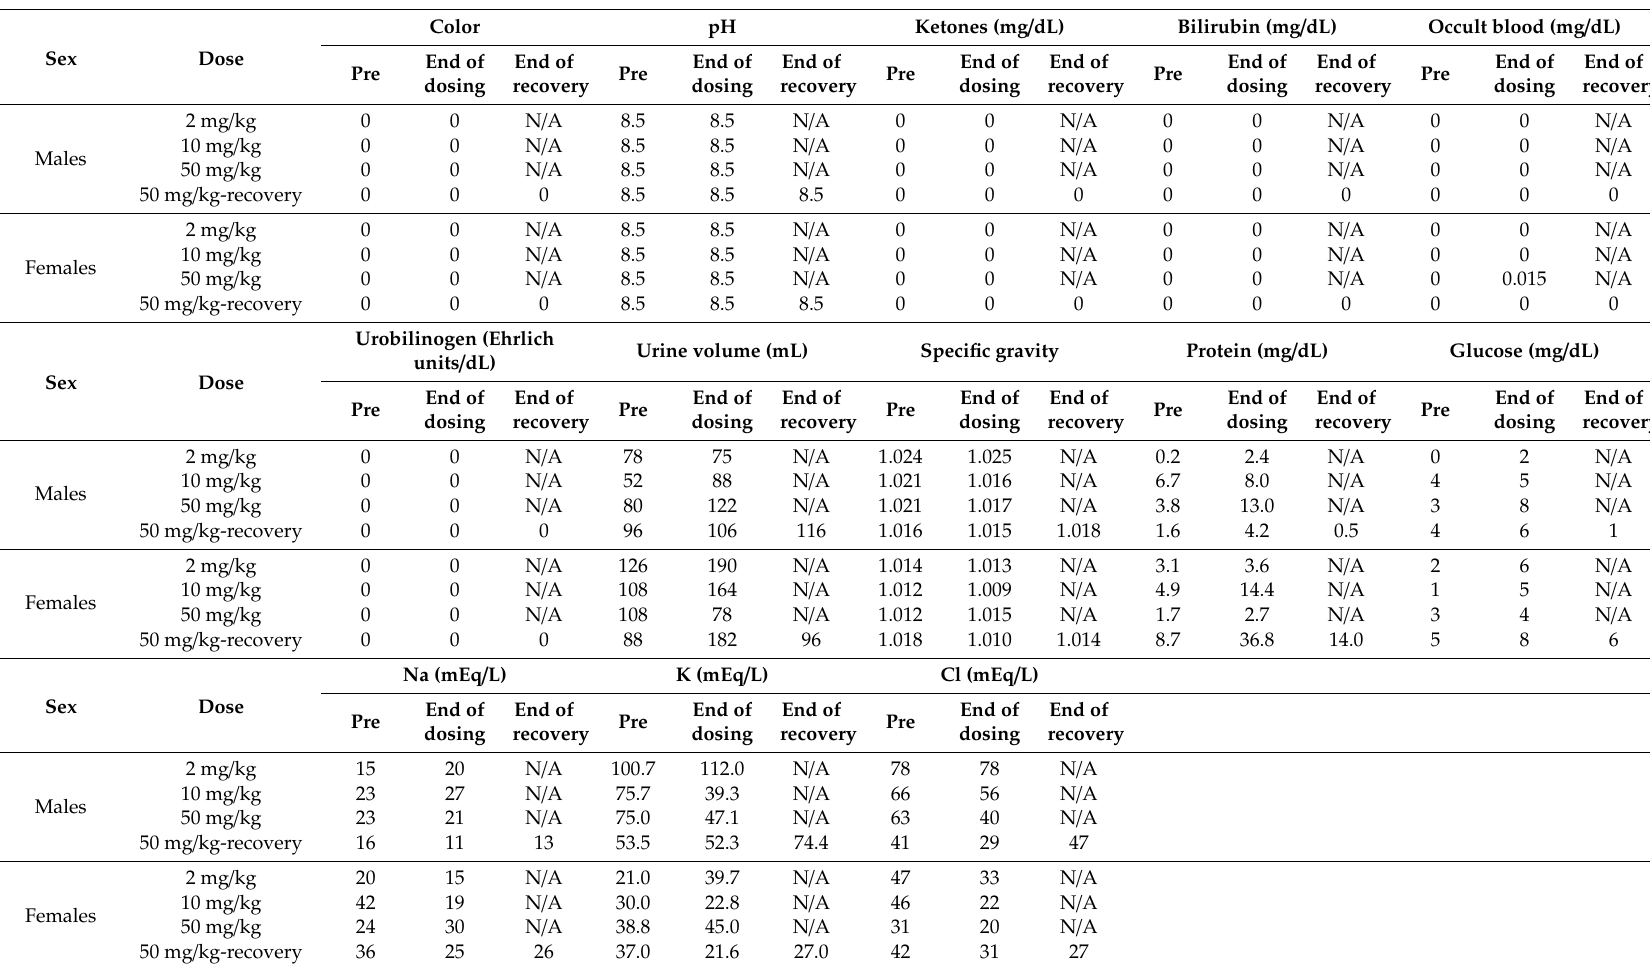
Table 5. Urinalysis in cynomolgus monkeys that received